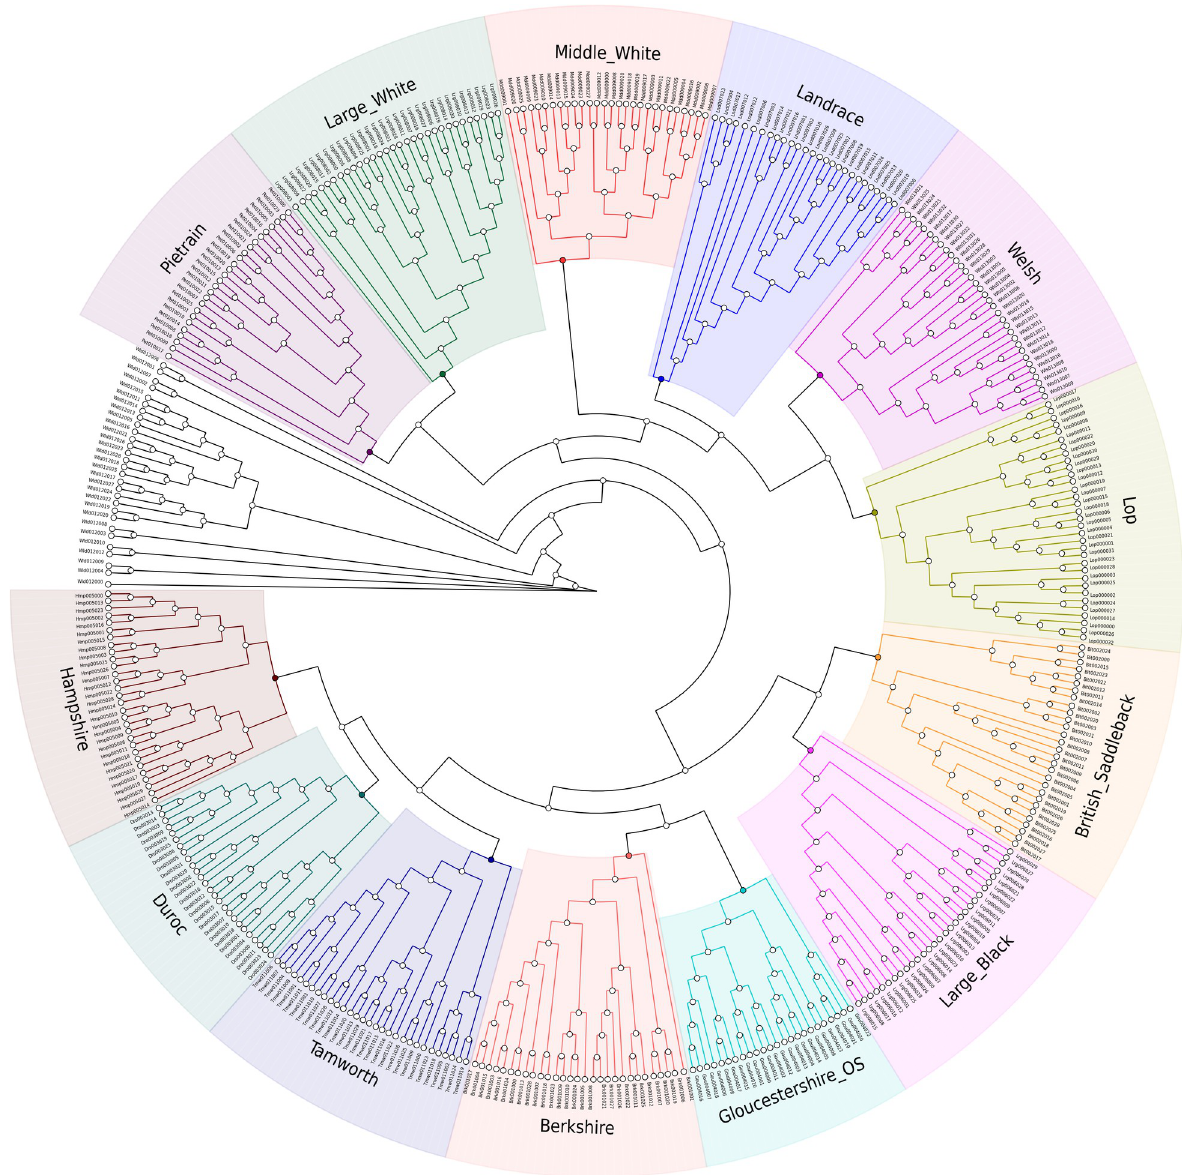
Fig 3. Neighbor-joining Identity-by-State (IBS) consensus tree for 14 pig populations. IBS genetic distances for 405 samples and 14,628 SNPs were estimated in PLINK with 100 bootstrap permutations, using PHYLIP and GraPhlAn to create the tree. Wild boar (in black) was used as